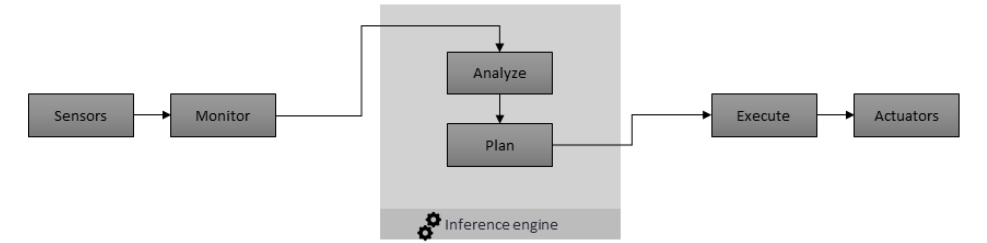
Figure 2. Inference engine based system flow.